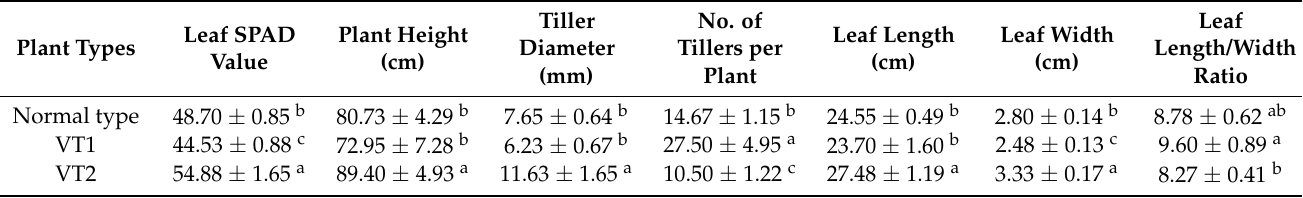
Figure 3. Morphological features of the aerial shoots and rhizomes of the three types of ginger plants at harvest. ( A , D ) the normal-type plant; ( B , E ) the VT1; ( C , F ) the VT2. Scale bars = 10 cm. Table 3. Main morphological parameters of the normal-type ginger and the two variation types at harvest.